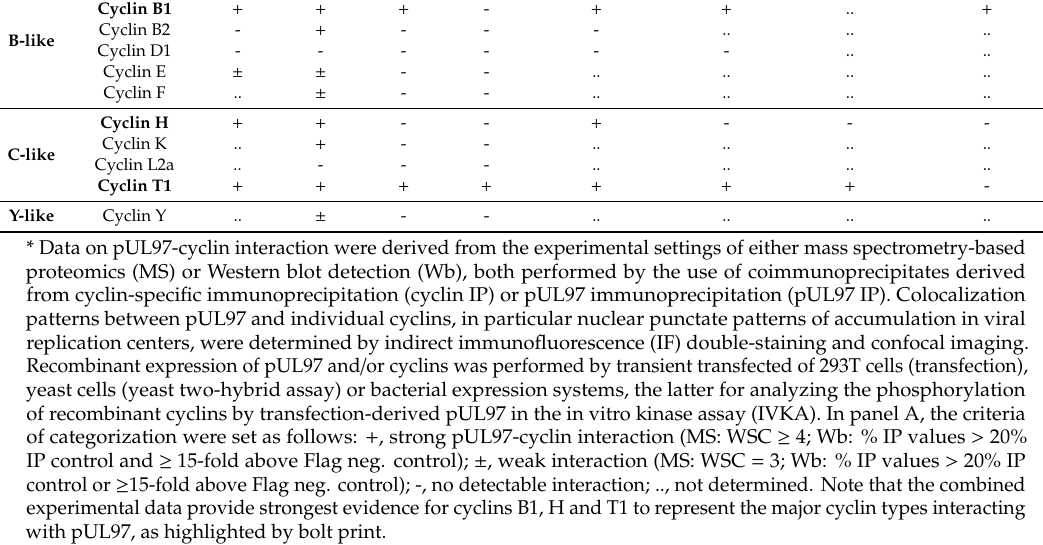
Table 2. Summarized findings of pUL97-cyclin interaction derived from complementary experimental settings *. A HCMV-Infected Cells B Recombinant Expression Phosphorylation Yeast Colocalization by pUL97 in Transfection Two-Hybrid Cyclin Types Cyclin IP MS | Wb pUL97 IP MS | Wb in IF IVKA System Cyclin A + ± - - .. .. .. .. Cyclin B1 + + + - + + .. + Cyclin B2 - + - - - .. .. .. B-like Cyclin D1 - - - - - - .. .. Cyclin E ± - - .. .. .. .. Cyclin F .. ± - - .. .. .. Cyclin H + + - - + - - - Cyclin K .. + - - .. .. .. .. C-like Cyclin L2a .. - - - .. .. + + + + + + + - Y-like Cyclin Y .. ± - - .. .. .. .. * Data on pUL97-cyclin interaction were derived from the experimental settings of either mass spectrometry-based proteomics (MS) or Western blot detection (Wb), both performed by the use of coimmunoprecipitates derived from cyclin-specific immunoprecipitation (cyclin IP) or pUL97 immunoprecipitation (pUL97 IP). Colocalization patterns between pUL97 and individual cyclins, in particular nuclear punctate patterns of accumulation in